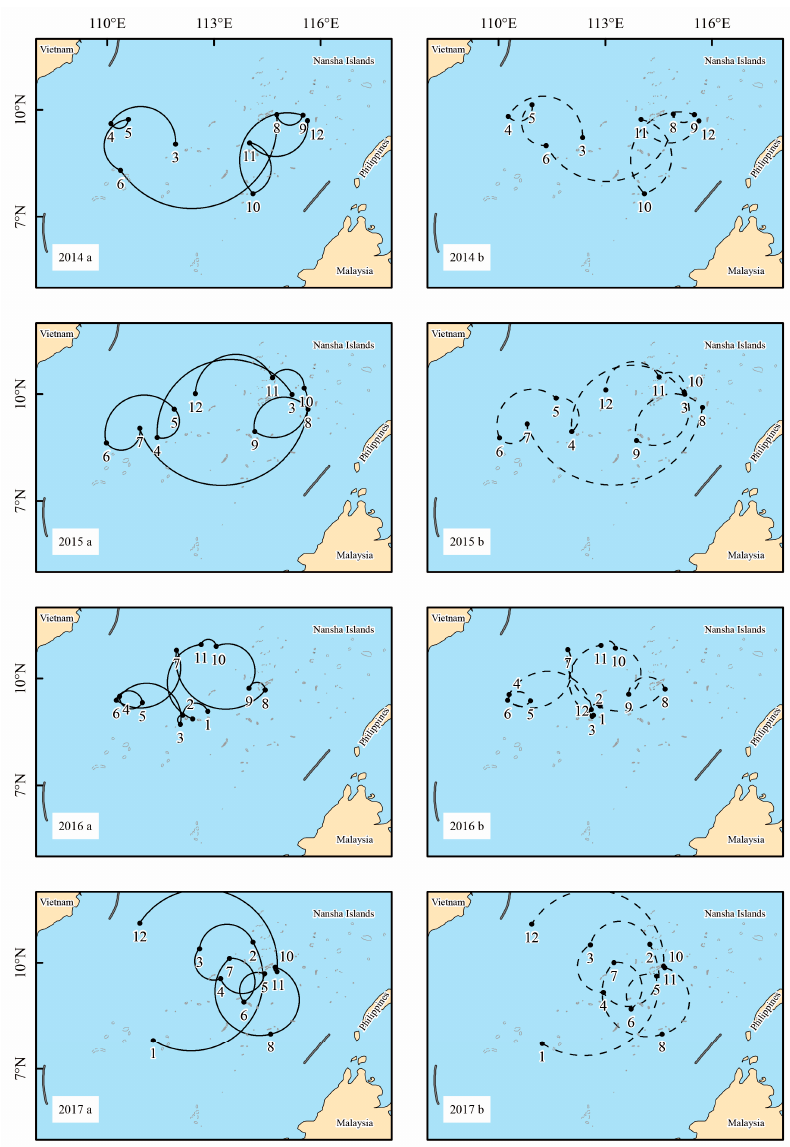
Figure 4. Monthly center of gravity distribution for 2014–2017 (Figure a plotted using AI-Effort projections, Figure b plotted using AI-Effort).